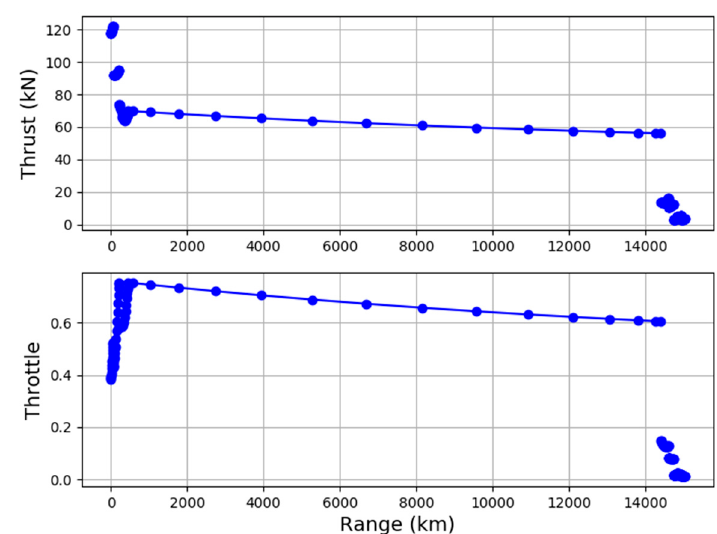
Figure A12. Thrust and throttle settings of SE²A-LR.